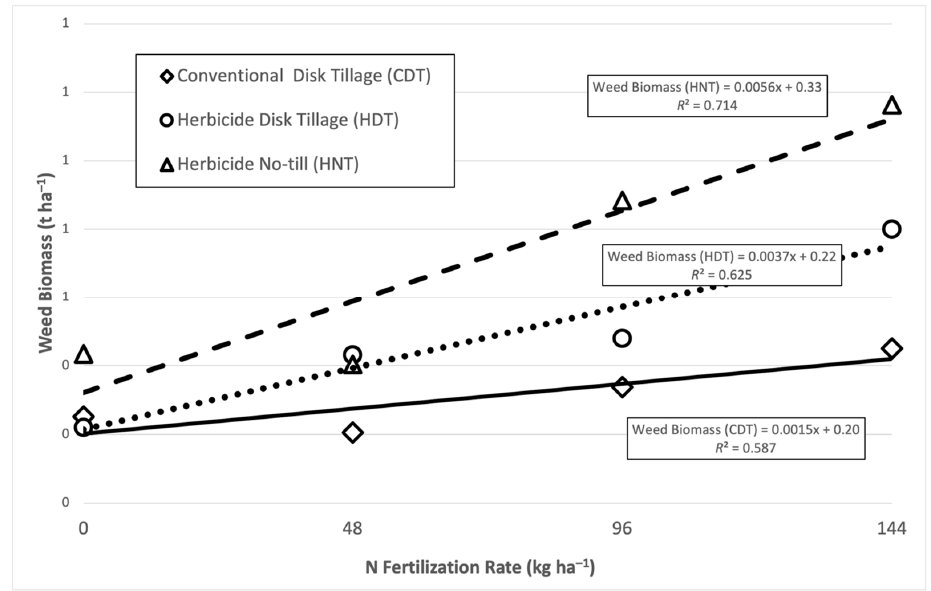
Figure 6. Interactive effect of N fertilization rate following different cover crop termination methods on weed biomass in 2020. Goodness of fit described with conditional R 2 .